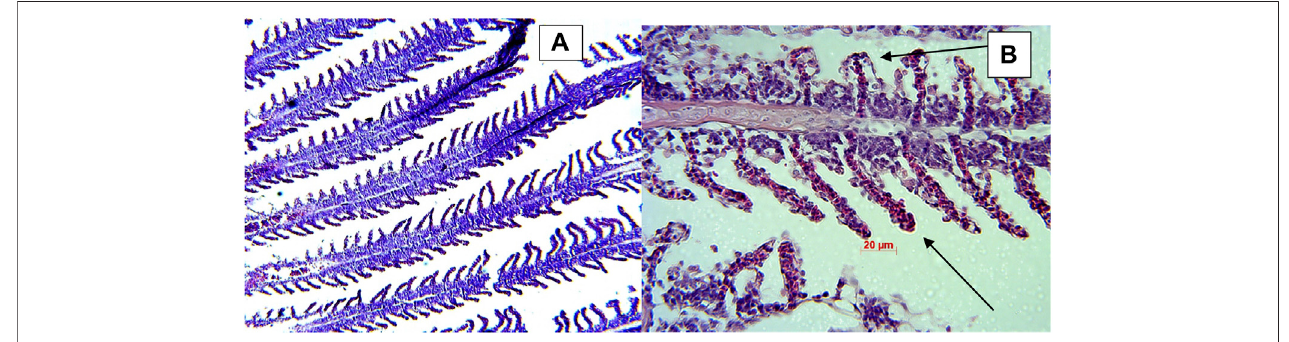
FIGURE 8 | Histology samples of gill tissue showing retention of normal gill structure in control fi sh (A) and clubbed gills indicated by black arrows columnaris infected fi sh (B)